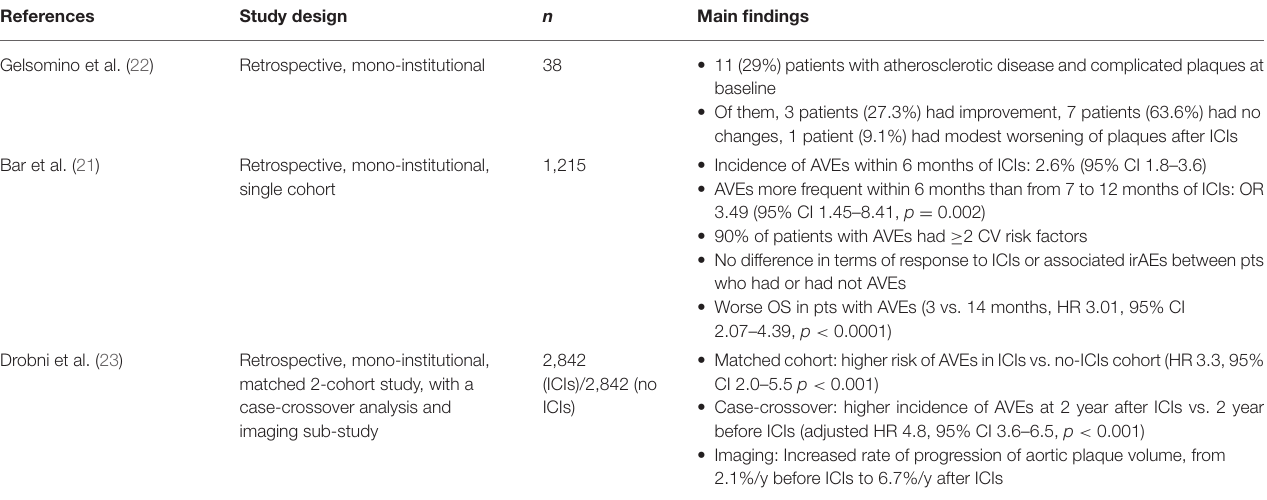
TABLE 3 | Retrospective studies.